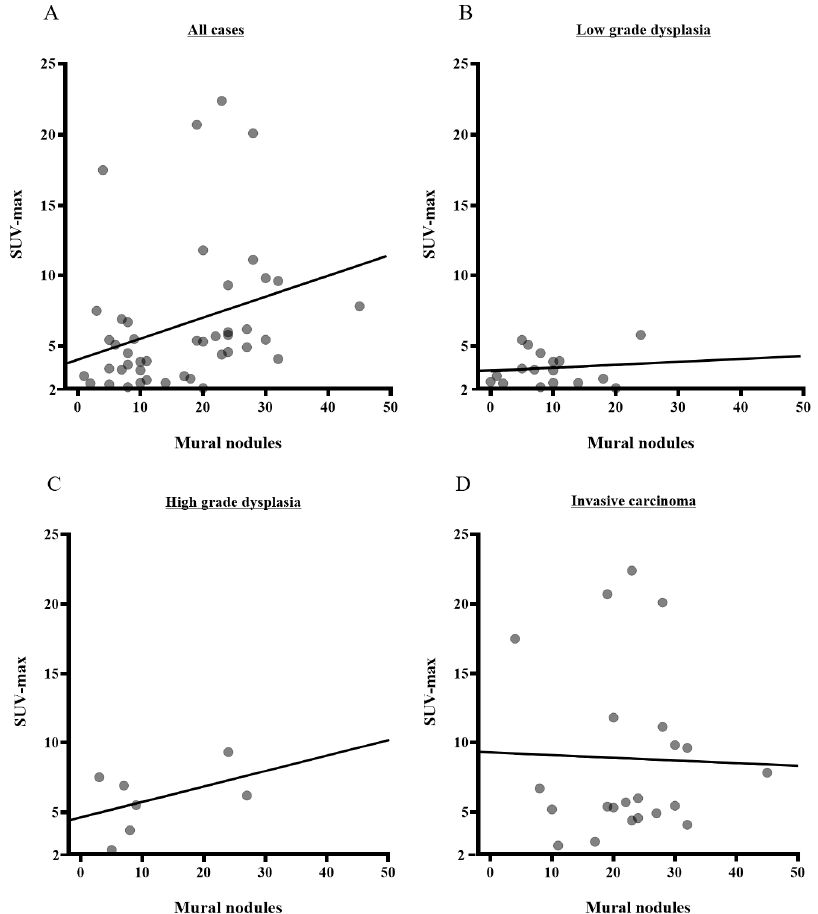
Figure 5. Correlations of the levels of SUV-max and mural nodule height by pathological grouping. ( A ) Significant correlations were found between mural nodule height and SUV-max in all IPMNs (R = 0.1474, p = 0.0463). ( B ) It was found that there was no significant correlation among LGDs (R = 0.2349, p = 0.6190). ( C ) It was found that there was no significant correlation among HGDs (R = 0.1113, p = 0.3074). ( D ) It was found that there was no significant correlation among INVs (R = − 0.1901, p = 0.8976). SUV-max: maximum standardized uptake value; IPMN: intraductal papillary mucinous neoplasm.